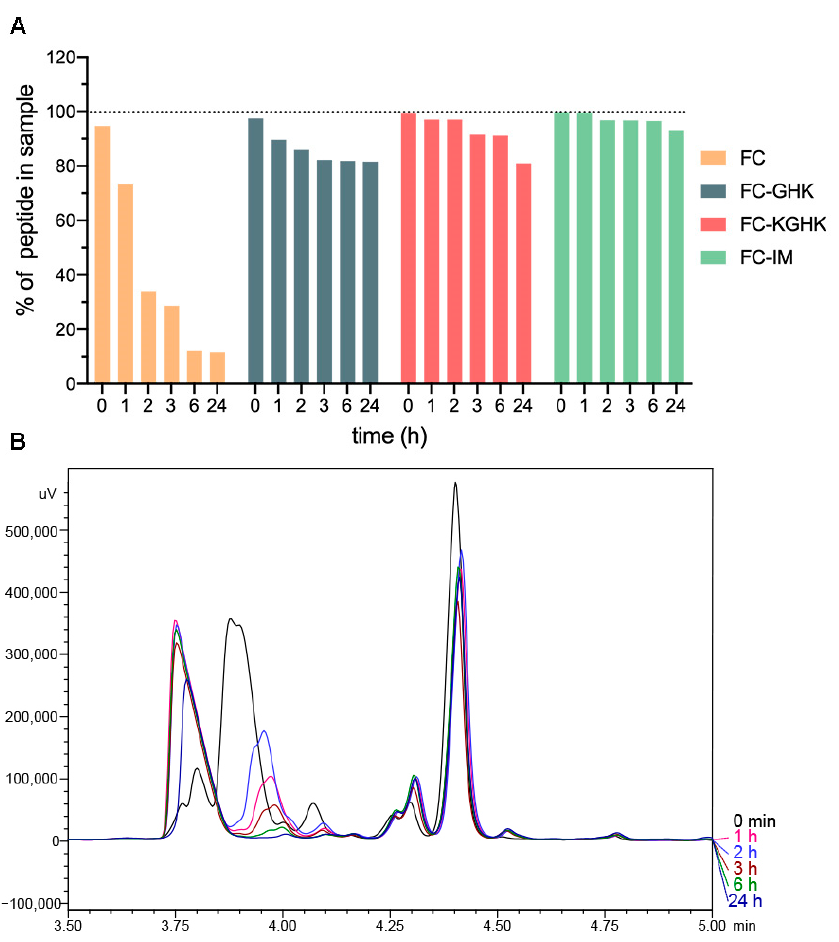
Figure 7. ( A ) Peptide stability with trichloroacetic acid (TCA) in human plasma and ( B ) fragment of the chromatogram (tR from 3.5 min to 5.0 min) of the FC peptide samples taken over 24 h of incubation.